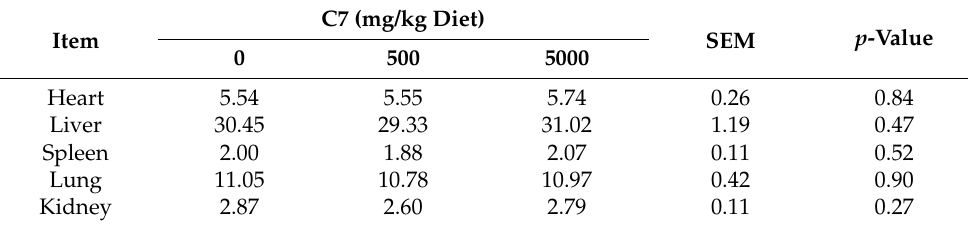
Figure 1. Representative images of small intestinal, liver, and kidney by H&E staining. Compared with the control group, C7 supplementation did not affect organ weight ( p > 0.05, Table 12). Table 12. Effect of high-dose C7 supplementation on organ weights (% BW) in weaned piglets.